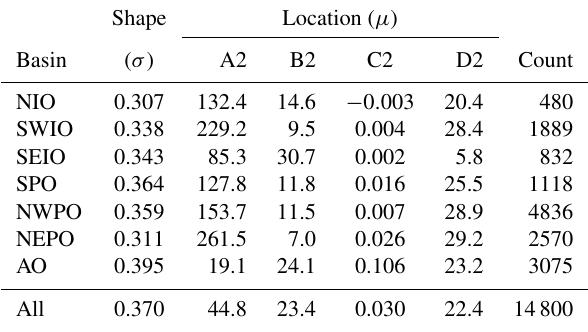
Table 1. Fitting coefficients for the lognormal RMW as described in Eq.